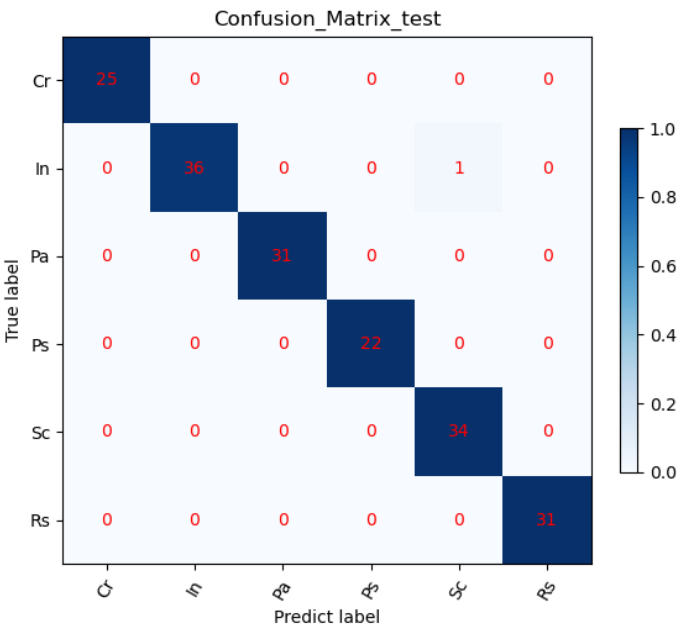
Figure 9. Confusion matrix.